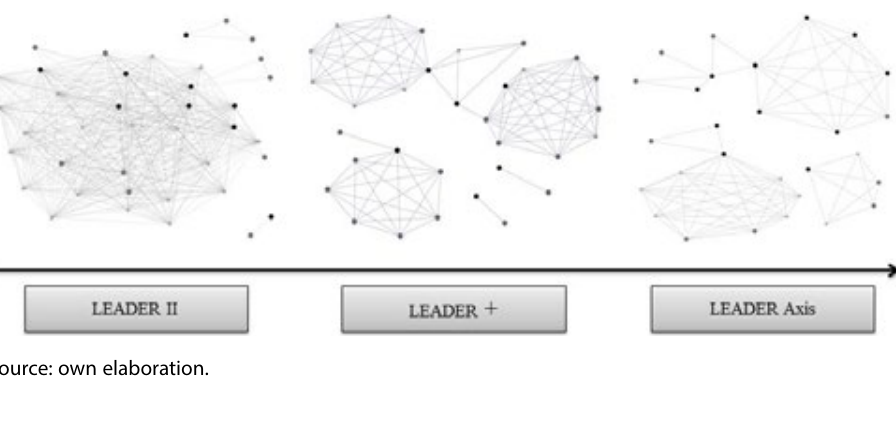
Figure 5. Evolution of TNC LEADER network in Veneto.